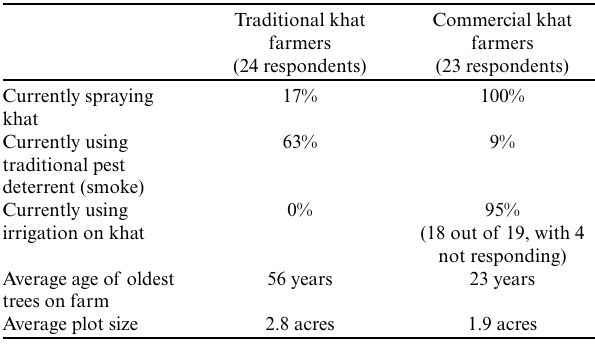
Table 3 . Farmer survey (47